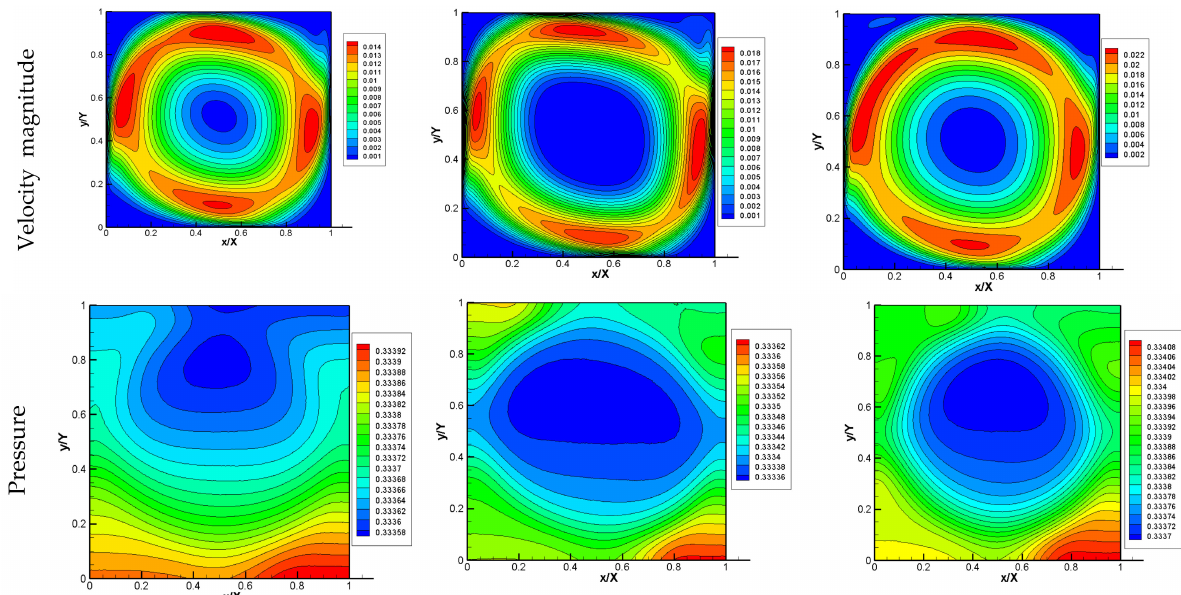
Figure 10. Steady state non-dimensional dynamic and thermal profiles behavior for different partially left boundary conditions at volume fraction φ and Ra = 10 5 .